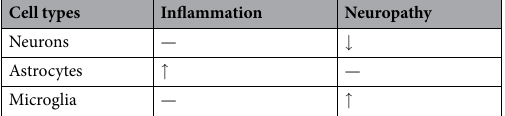
Table 1. Changes of DPP4 expression of different cell types in pathological conditions. A brief summary of how DPP4 expression changes in different cell types in different pathological conditions. Increases and decreases are indicated by upward and downward arrows,